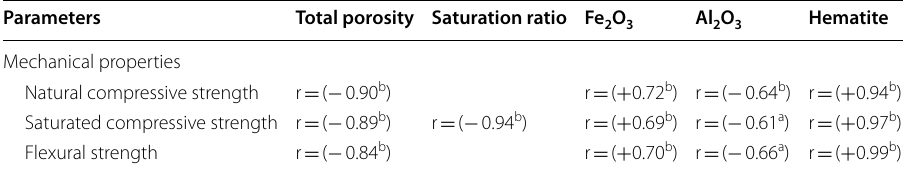
R, Coefficient of correlation; a threshold of significance (p ˃ 0.01); b threshold of significance (p ˃ 0.05)